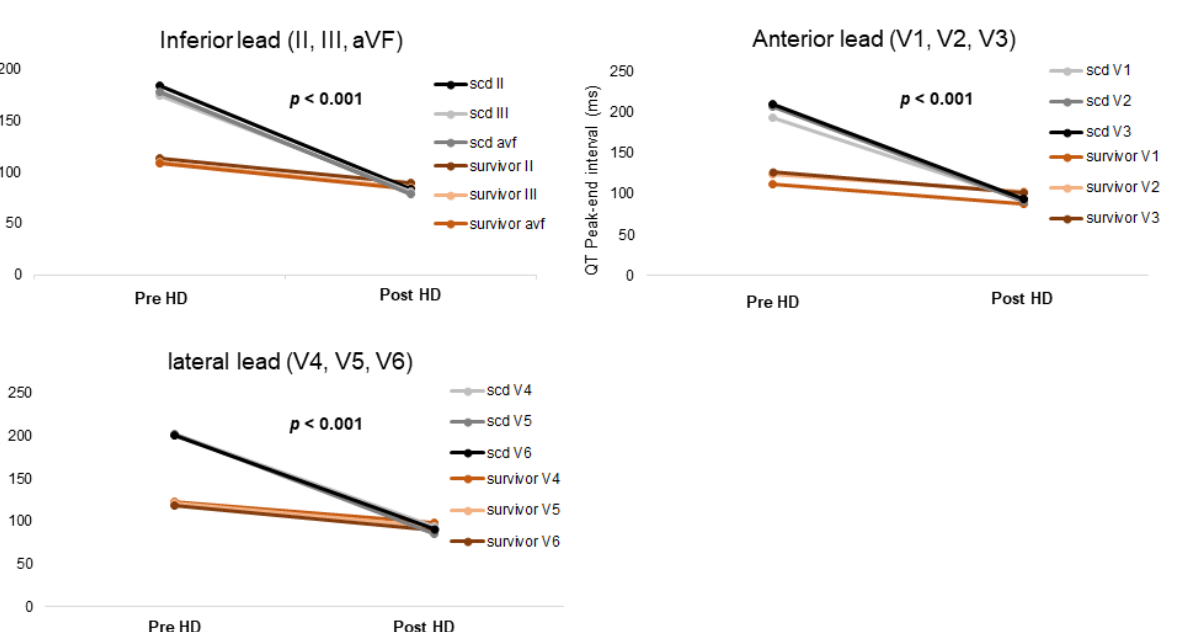
Table 5. Cox analysis of the risk of sudden cardiac death predicted by ECG parameters.